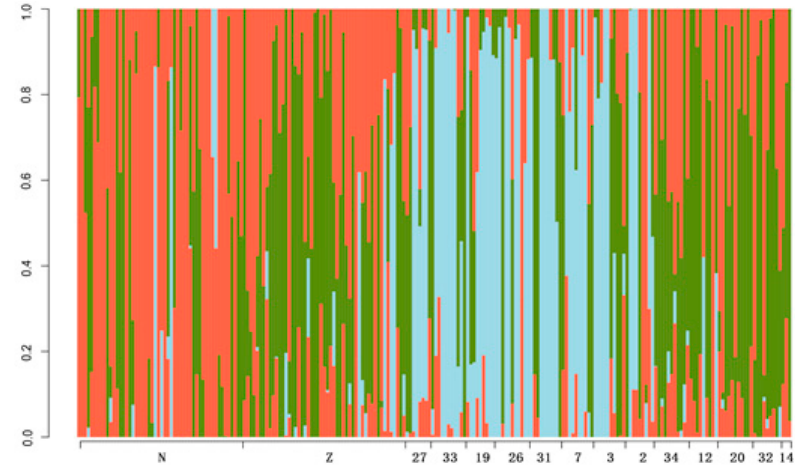
Figure 6. Structure bar plots for 15 populations of P. trituberculatus ( K = 4). “N” and “Z” stand for crabs caught from Nantong and Zhoushan.